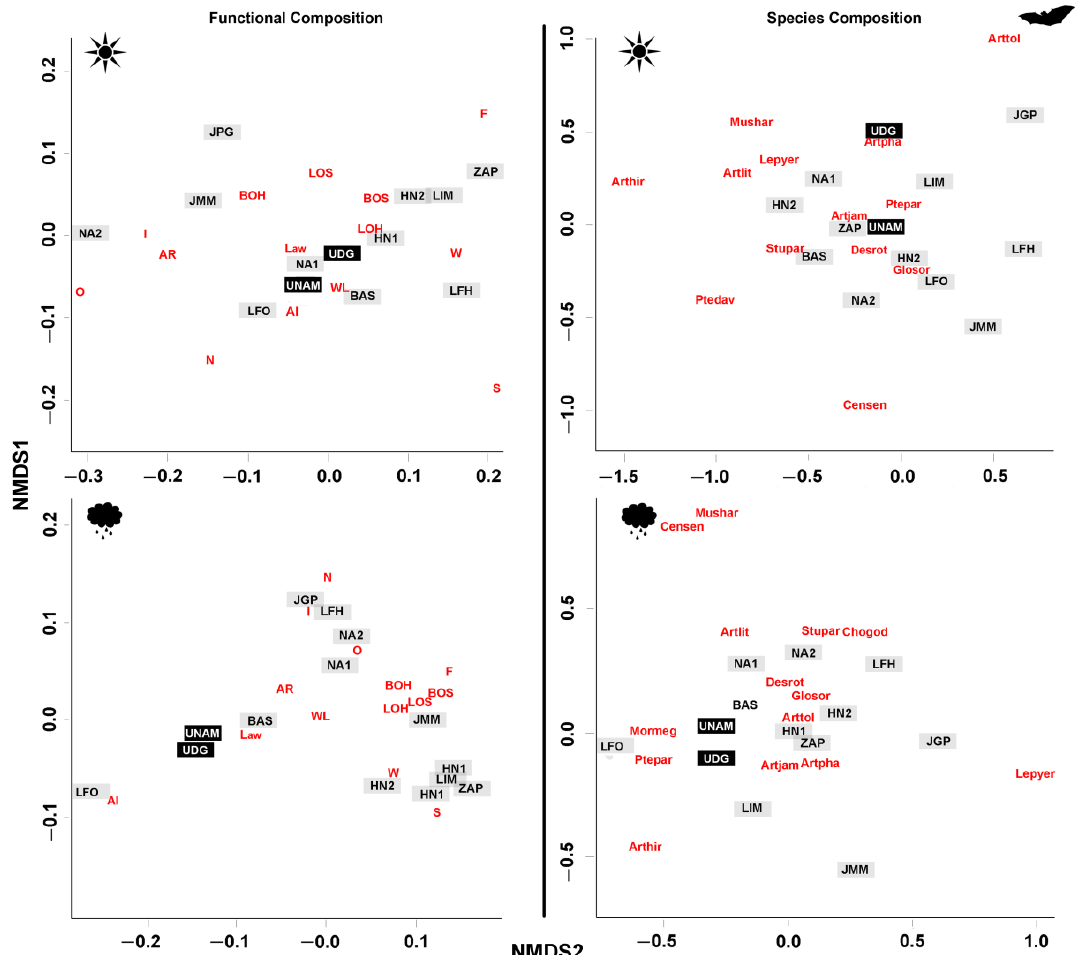
Figure 2. Ordinations (non-metric multidimensional scaling, NMDS) of bat assemblages based on its functional ( left charts ) and species composition ( right charts ) during the dry ( above charts ) and rainy season ( below charts ). The squares correspond to study sites, showing in gray the early successional sites and in black the old growth forest sites. In the left charts, functional traits are shown in red and capital letters. In the right charts, the species are shown in red and lowercase letters. Functional